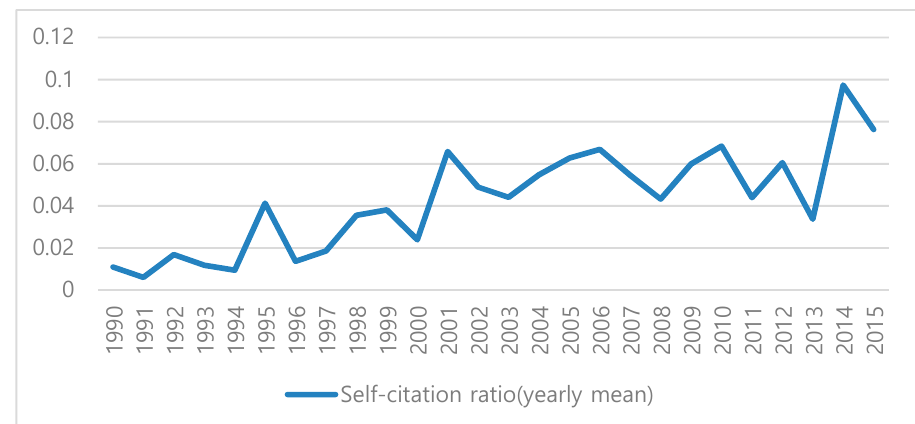
Figure 7. Average self-citation ratio of Korean firms.